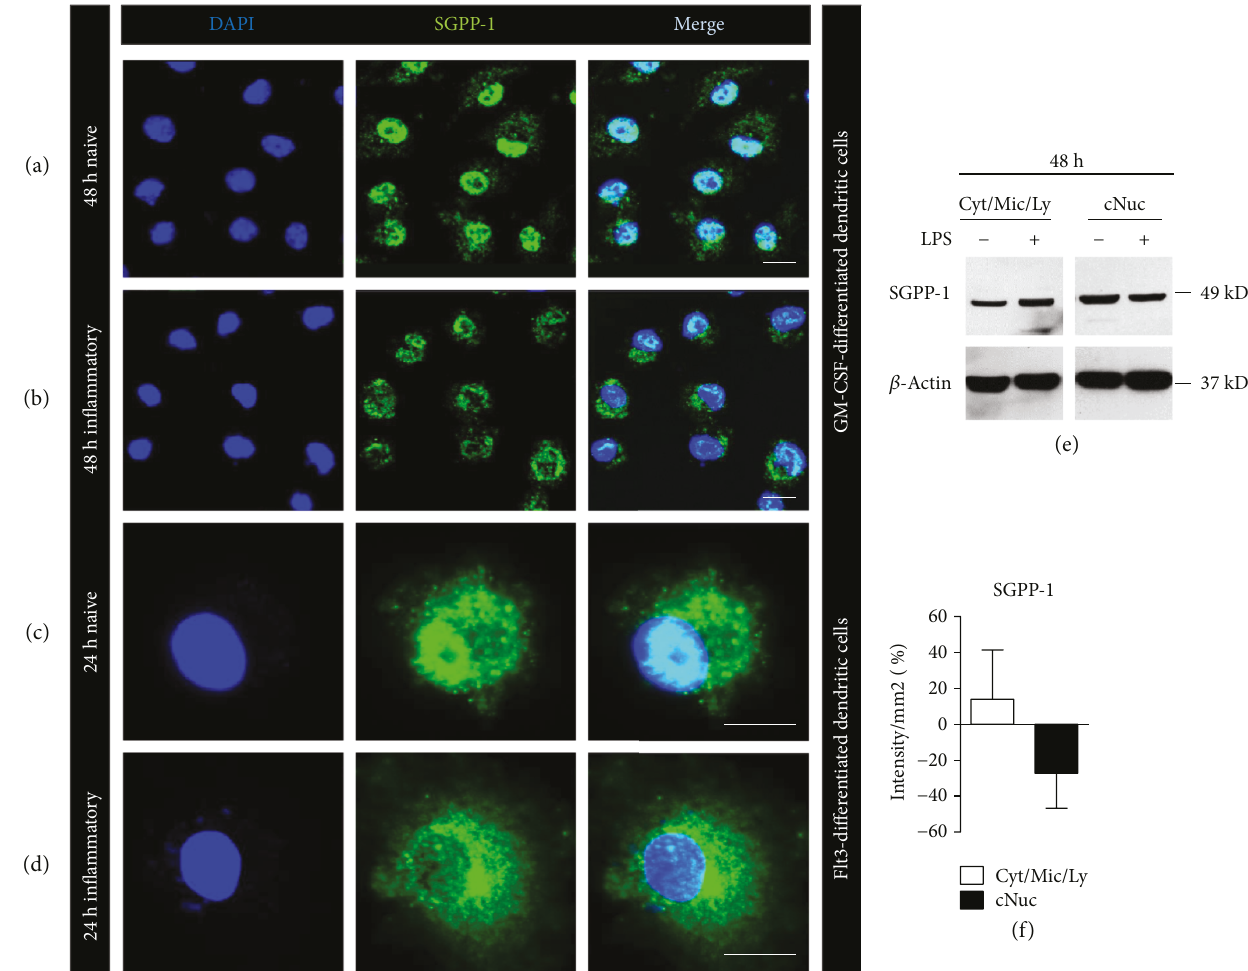
Figure 2: (a, b) Representative pictures of confocal laser microscopy of untreated mature GM-CSF-di ff erentiated CD11c + dendritic cells after 48h of starvation (naive) and 48 h of LPS stimulation (in fl ammatory) stained with DAPI (blue) and anti-SGPP-1 (green) ( n = 7 ). (c, d) Representative pictures of confocal laser microscopy of untreated mature Flt3-di ff erentiated CD103 + dendritic cells after 24 h of starvation (naive) and 24 h of LPS stimulation (in fl ammatory) stained with DAPI (blue) and anti-SGPP-1 (green) ( n = 2 ). (e) Representative Western blot stained with anti-SGPP-1 antibody and anti- β -actin antibody in crude cytosolic (Cyt/Mic/Ly; Cyt=cytosol, Mic=microsomes, and Ly=lysosomes) and crude nuclear (cNun) fraction of cell lysates of naive GM-CSF-di ff erentiated dendritic cells or 48h upon LPS stimulation ( n = 3 ). (f) Quanti fi cation of Western blot bands of anti-SGPP-1 staining after stimulation with